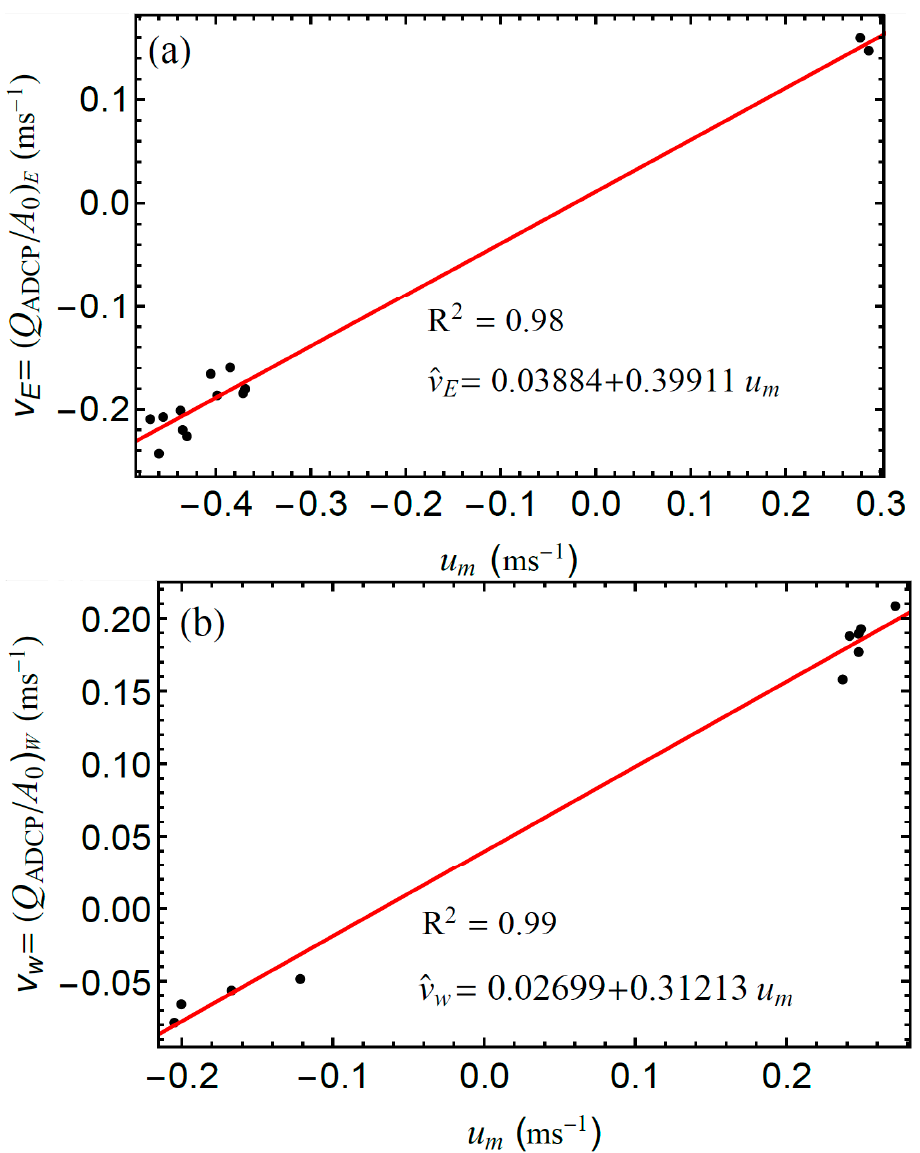
Figure 3. Index velocity relations for the (a) eastern and (b) western branches.